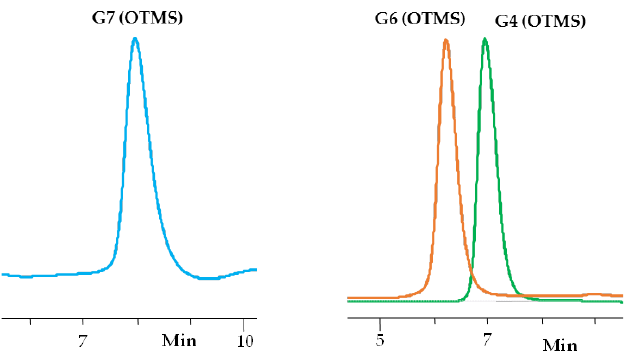
Figure 1. Gel Permeation Chromatography (GPC) curves of the obtained carbosilane-siloxane dendrimers (MSOCSD G4 (OTMS), and G6 (OTMS), G7 (OTMS)) after chromatographic